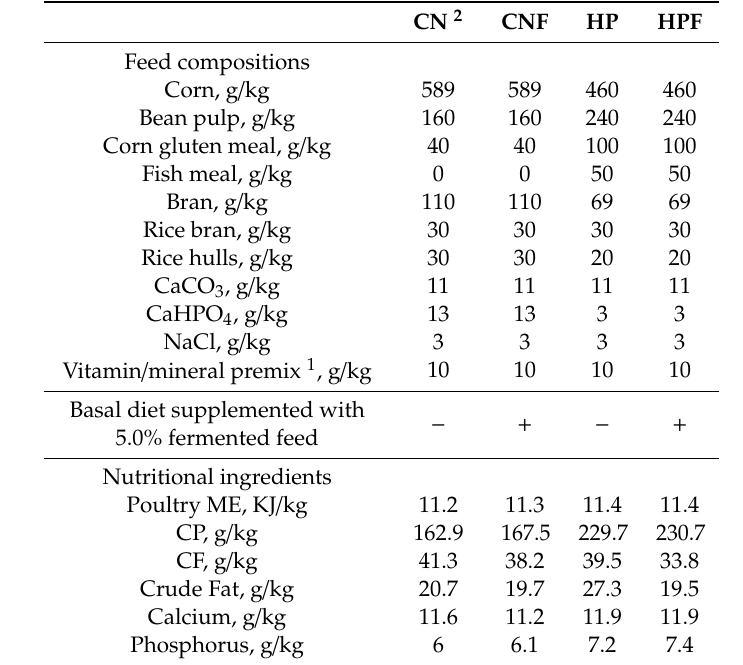
Table 2. Composition of experimental diets (1–35 days) in Experiment